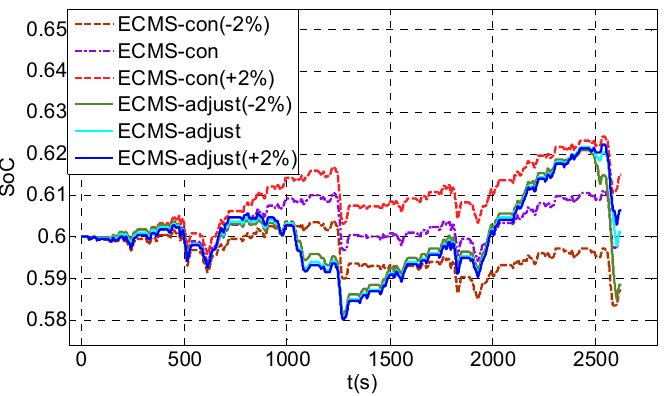
Figure 14. SoC trajectories for different control strategies (2 × China city bus cycle (CHA)).